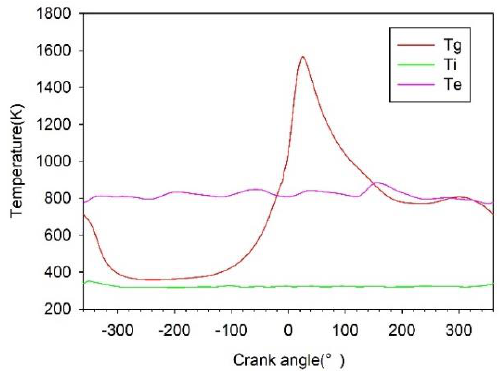
Figure 4. Curves of the transient temperature.